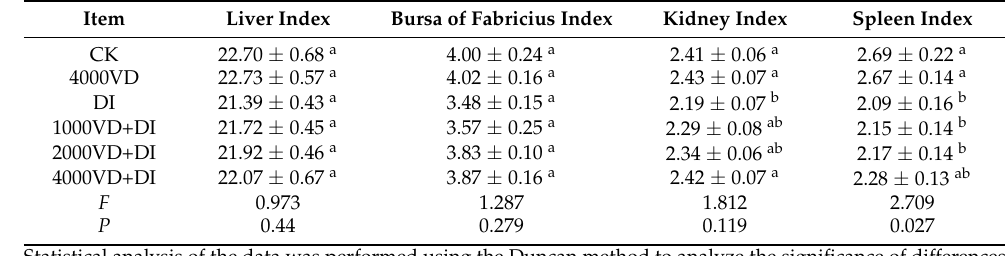
Table 4. Organ index of the Wenchang chicken